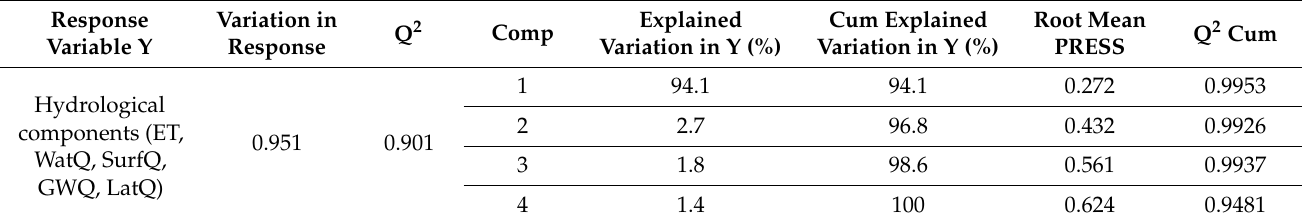
Table 5. Results of the partial least squares regression (PLSR) model of the hydrological components in the KWK watershed.